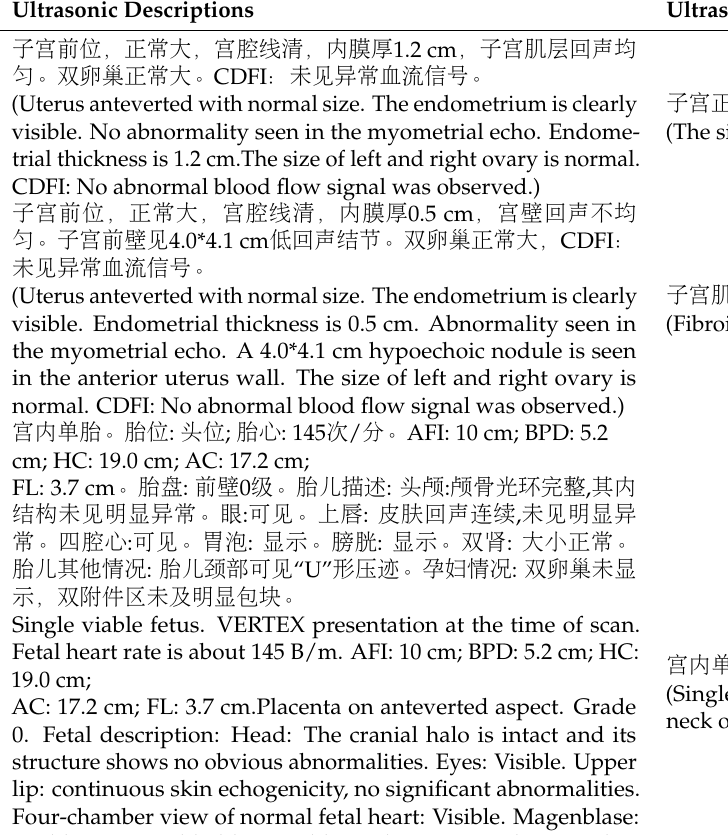
Table 1. Examples in the